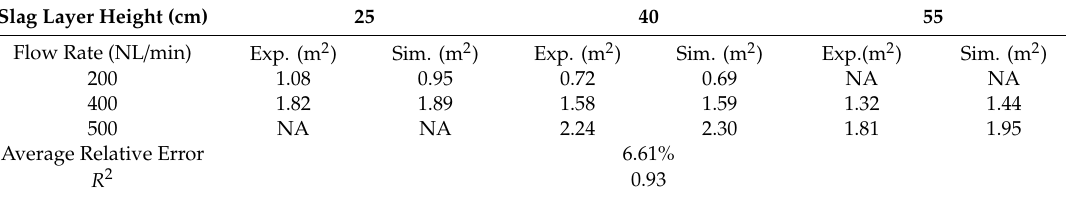
Table 2. Summary of experimental and simulated values for open-eye area with various gas flow rates and slag layer height.